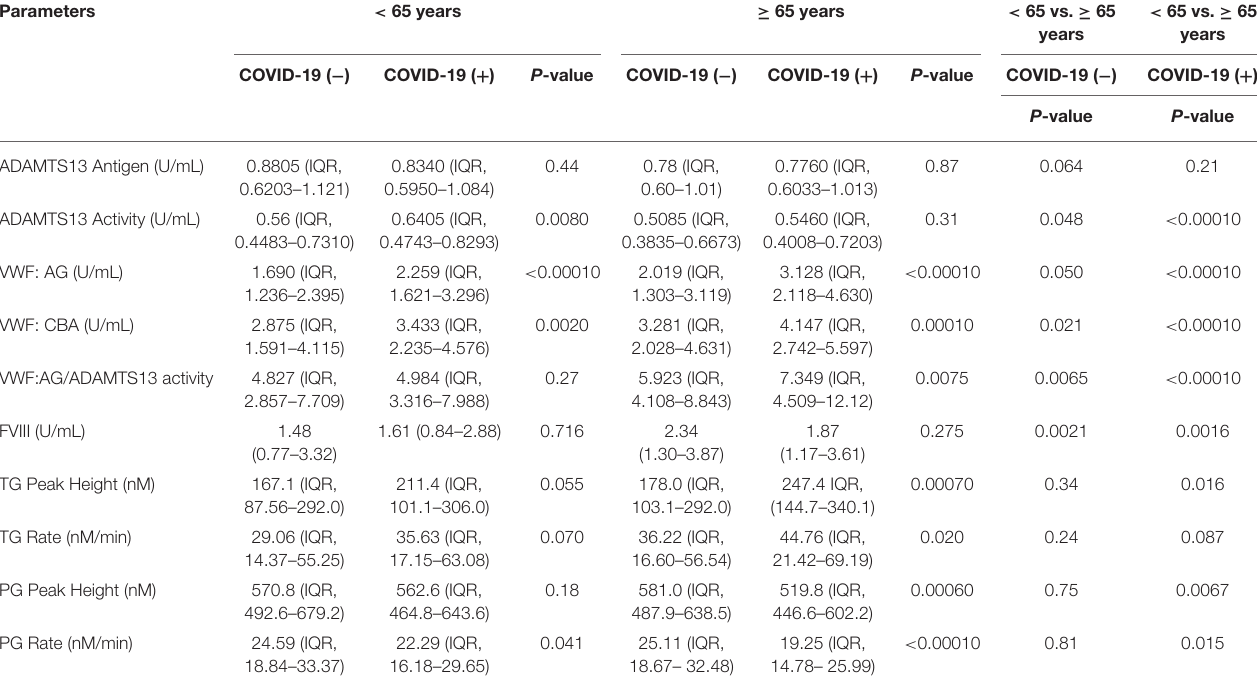
TABLE 2 | VWF, ADAMTS13, thrombin generation, and plasmin generation characteristics by age grouping.